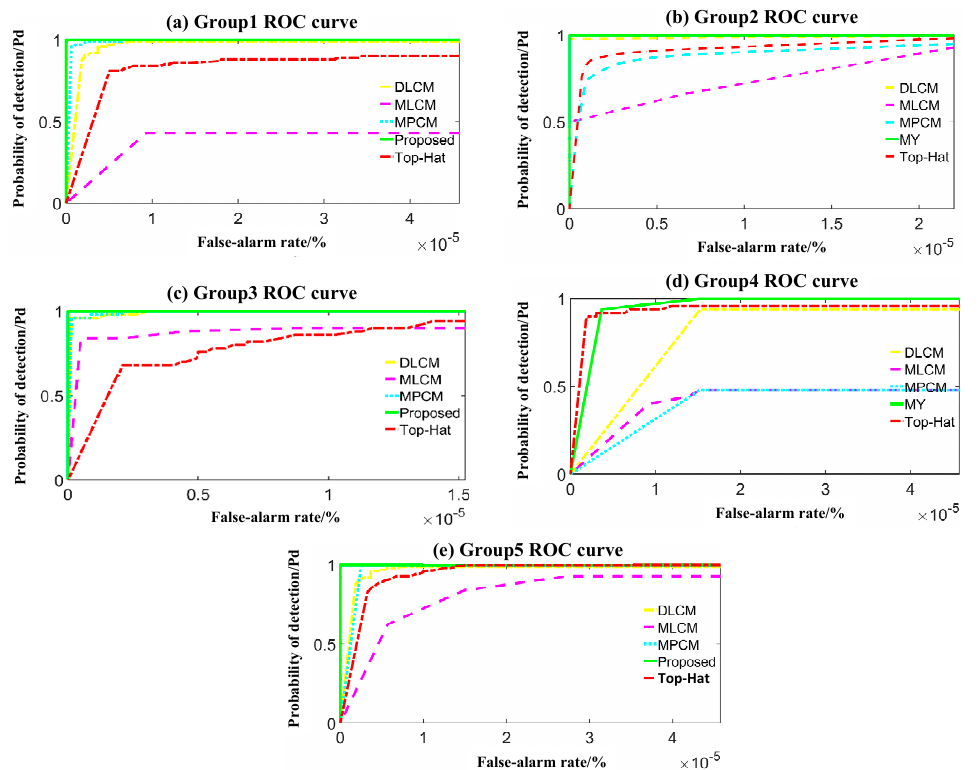
Figure 7. ( a ) ROC curve of sequence 1 after algorithm processing; ( b ) ROC curve of sequence 2 after algorithm processing; ( c ) ROC curve of sequence 3 after algorithm processing; ( d ) ROC curve of sequence 4 after algorithm processing; (e) ROC curve of sequence 5 after algorithm processing.